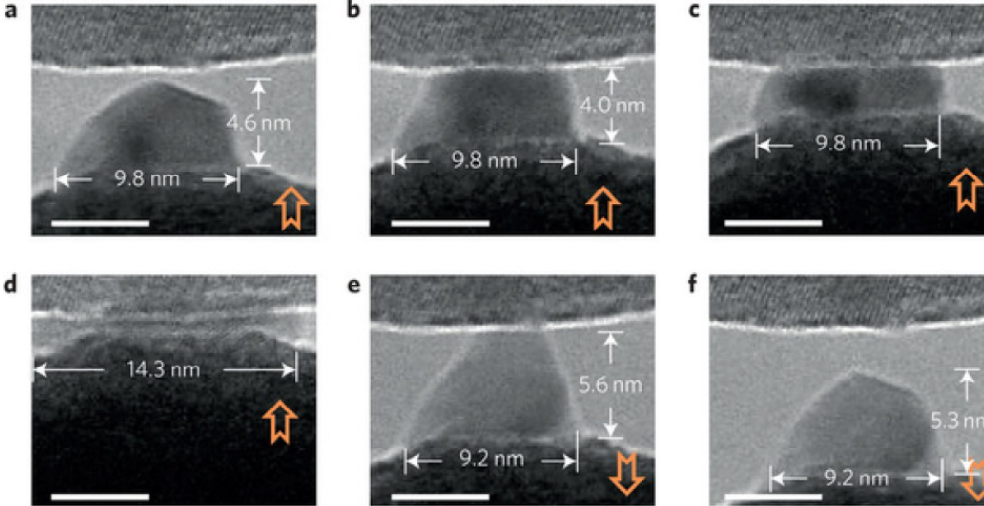
Fig. 21. Reversible pseudoelastic deformation of the Ag nanoparticles. (a-d) The Ag nanocrystal underwent a compression and (e, f) stretching cycle, almost recovered its initial size (a). Scale bars, 5 nm. The orange arrows indicate the movement direction of the W tip. Reprinted with permission from Henry CR. 2014.